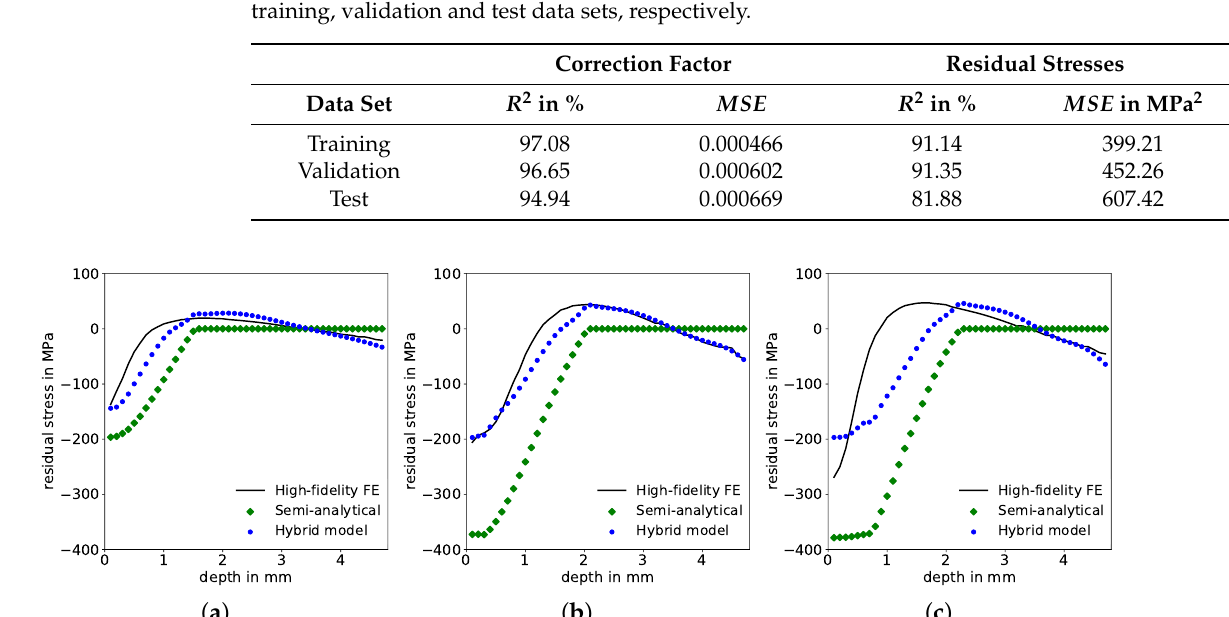
Figure 7. Comparison of residual stress distributions over depth predicted by the FE model, semi-analytical model and hybrid model for three exemplary test samples with pulse parameters maximum pressure P max , time of maximum pressure t I and pulse duration t II of ( a ) 1236 MPa, 15.1 ns, 85 ns; ( b ) 1639 MPa, 37.7 ns, 145 ns; and ( c ) 1820 MPa, 13 ns, 65.7